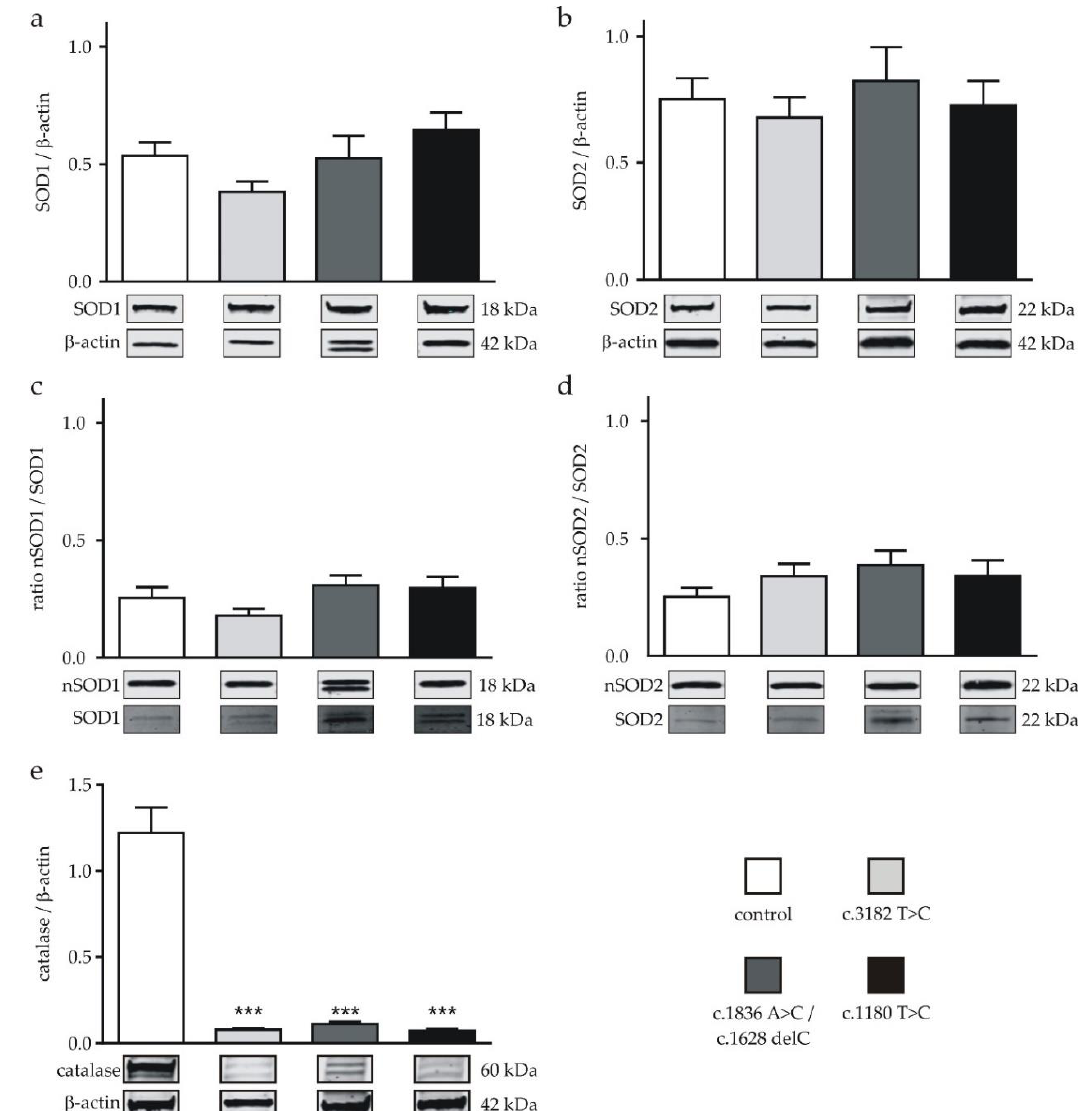
Figure 3. Protein expression of SOD and nitrated (n)SOD and catalase in neuronal differentiated cells. ( a ) Expression of SOD1 and ( b ) SOD2 of all NPC1-deficient cell lines was not different to the corresponding amounts in the control cell line ( n = 10–13). ( c ) The ratio of the nitrated proteins located at the 22-kDa (nSOD1) band to the total SOD1 and ( d ) the ratio of nitrated proteins located at the 22-kDa (nSOD2) band to the total SOD2 were similar in all cell lines ( n = 4–13). ( e ) The expression of catalase was significantly lowered in all NPC1-deficient cell lines ( n = 10–13). Double bands, observed for catalase, most likely represent isoforms of the protein. Western blot bands display corresponding examples of the same gel. An example of a complete gel is shown in Supplementary Figure S3. *** = p < 0.001. Statistical tests used: (a–e) ordinary one-way ANOVA with Dunnett´s multiple comparisons test. See also the Materials and Methods section.